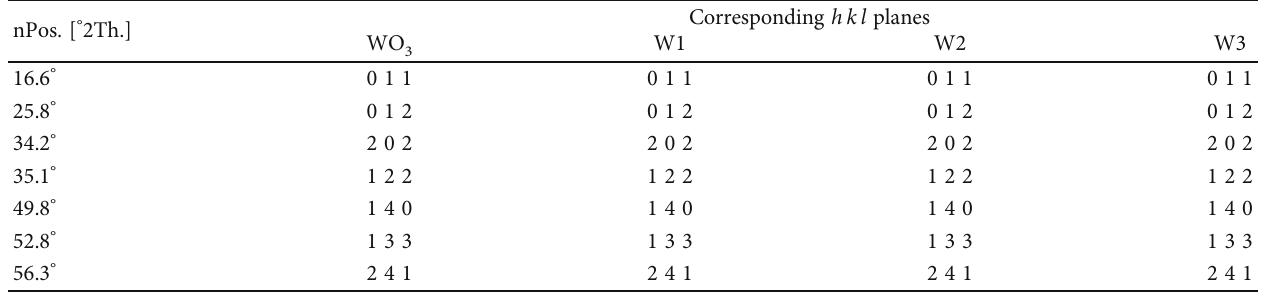
nanoparticles using sodium tungstate. 3 nanoparticles. 3